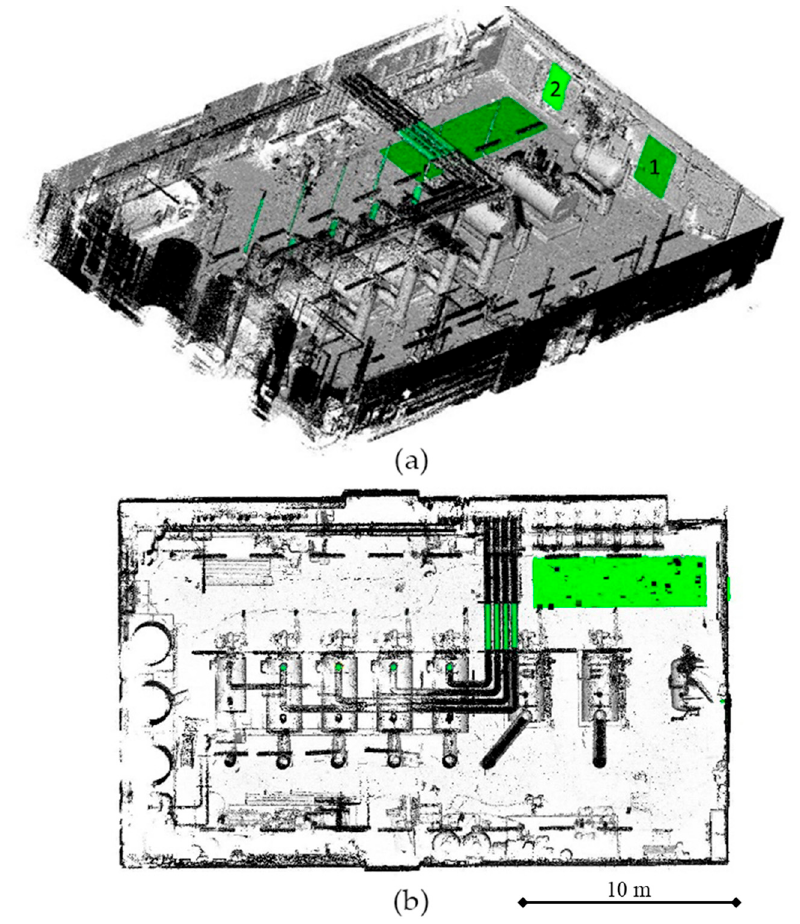
Figure 6. Different regions of interest used to fit the cylinders and planes (marked in green). The wall planes 1 and 2 are numbered in ( a ); while the floor planes and pipes highlighted are also shown in ( b ).